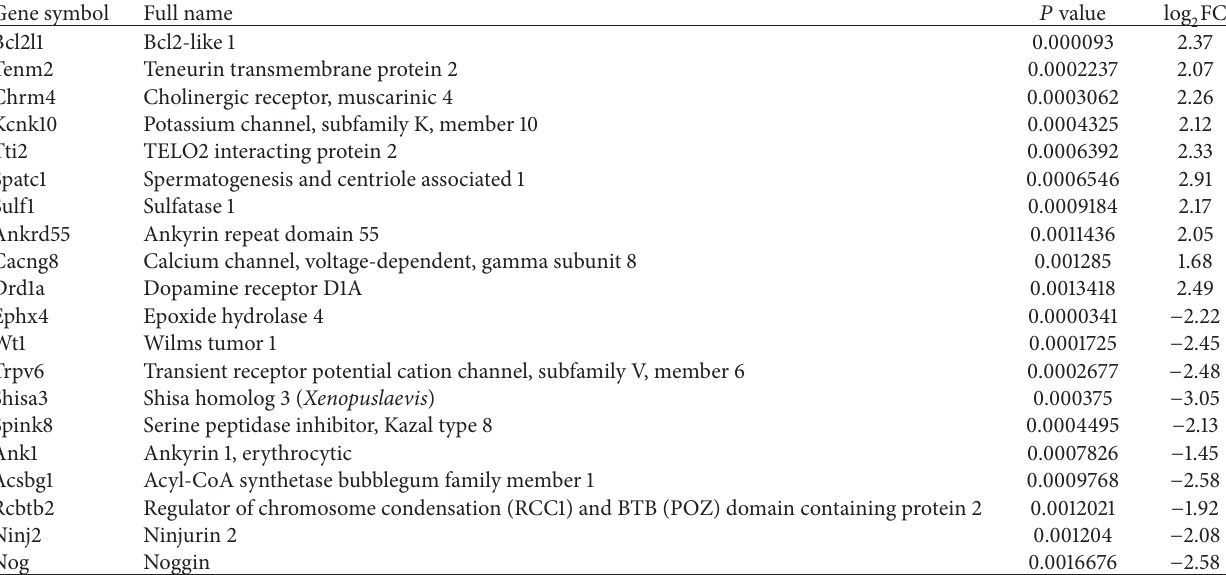
Table 2: The most significant upregulated and downregulated DEGs (top 10 of each) from later stage. Gene